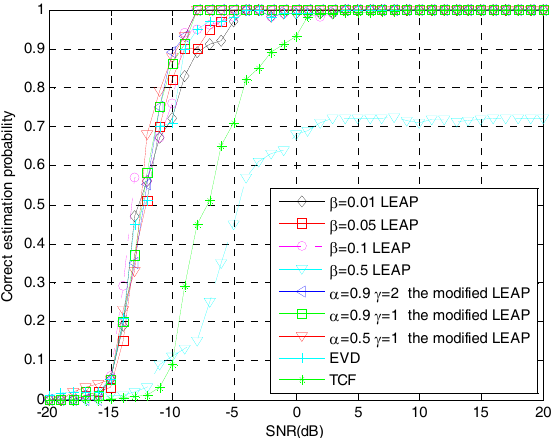
sunder different SNRs.